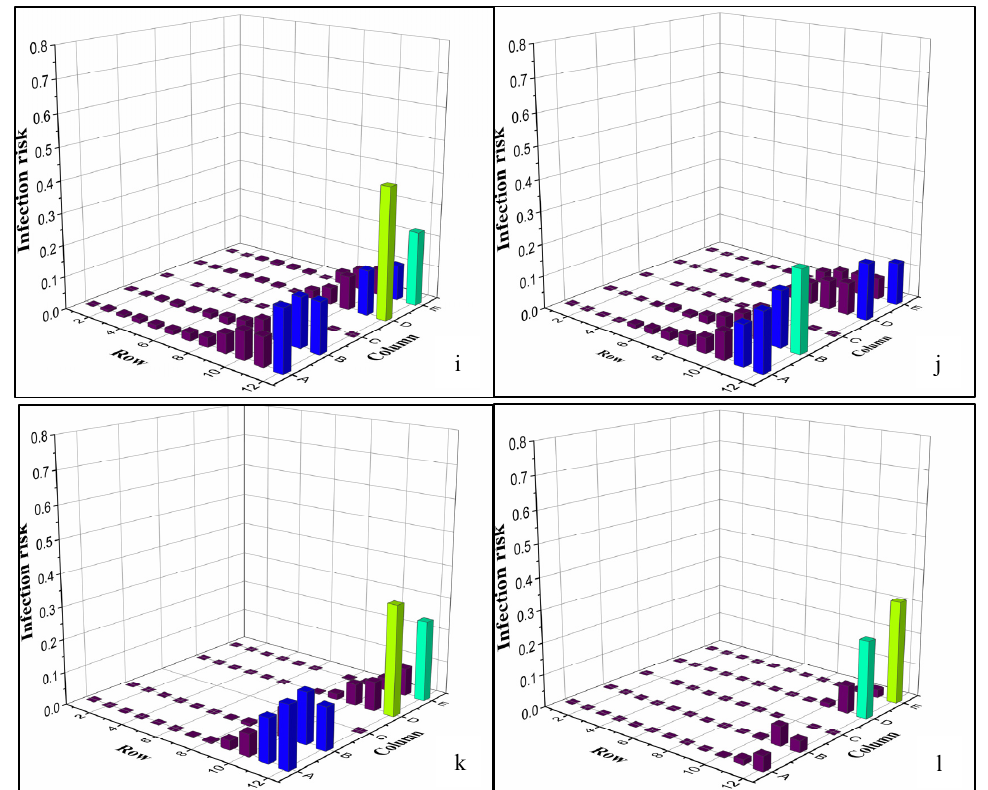
Figure 11. Infection risk of every individual passenger ( a ) Case 1.1, ( b ) Case 2.1, ( c ) Case 3.1, ( d )